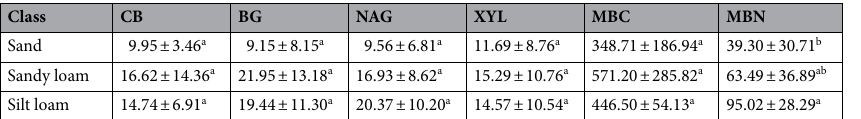
Table 2. Enzyme activities of soil and microbial biomass carbon and nitrogen. Mean ± standard deviation. Small letters in the upper index of the mean values mean significant differences between texture class. CB